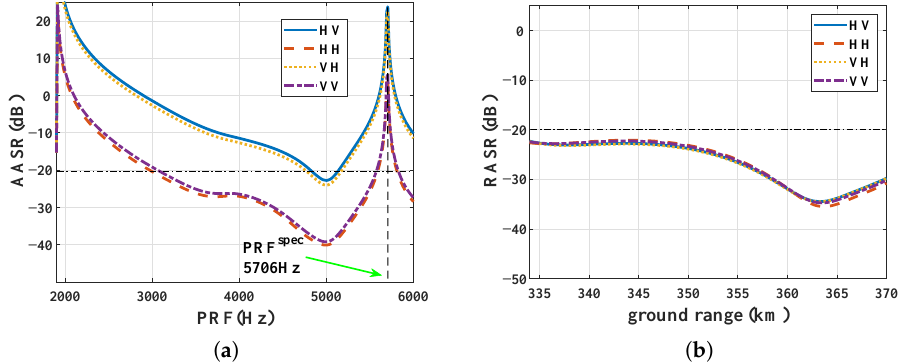
Figure 9. AASR and RASR performance of system #3 by MI method. ( a ) the AASR versus PRF. ( b ) the RASR (PRF = 3756 Hz) versus the ground